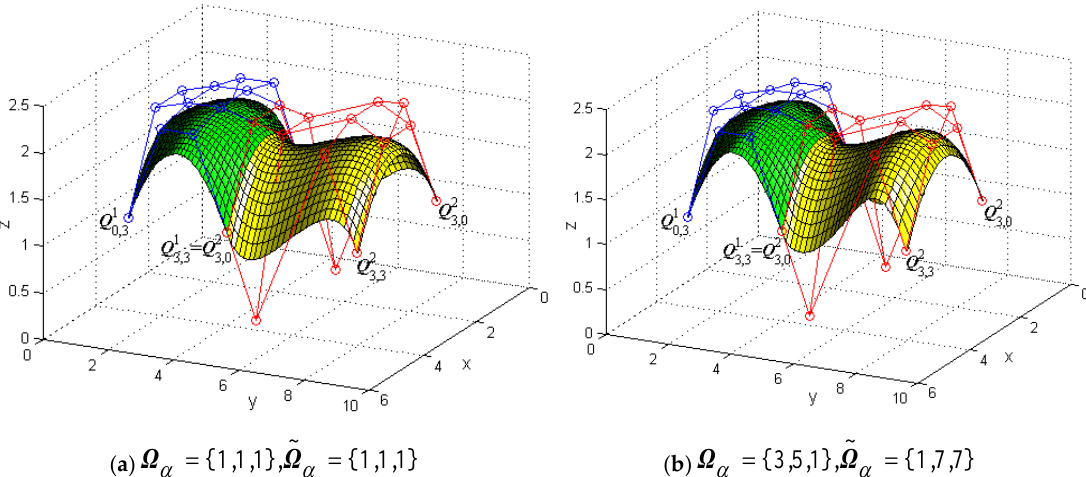
Figure 10. Generalized bicubic H-Bézier surfaces with G 1 continuity in the v direction.